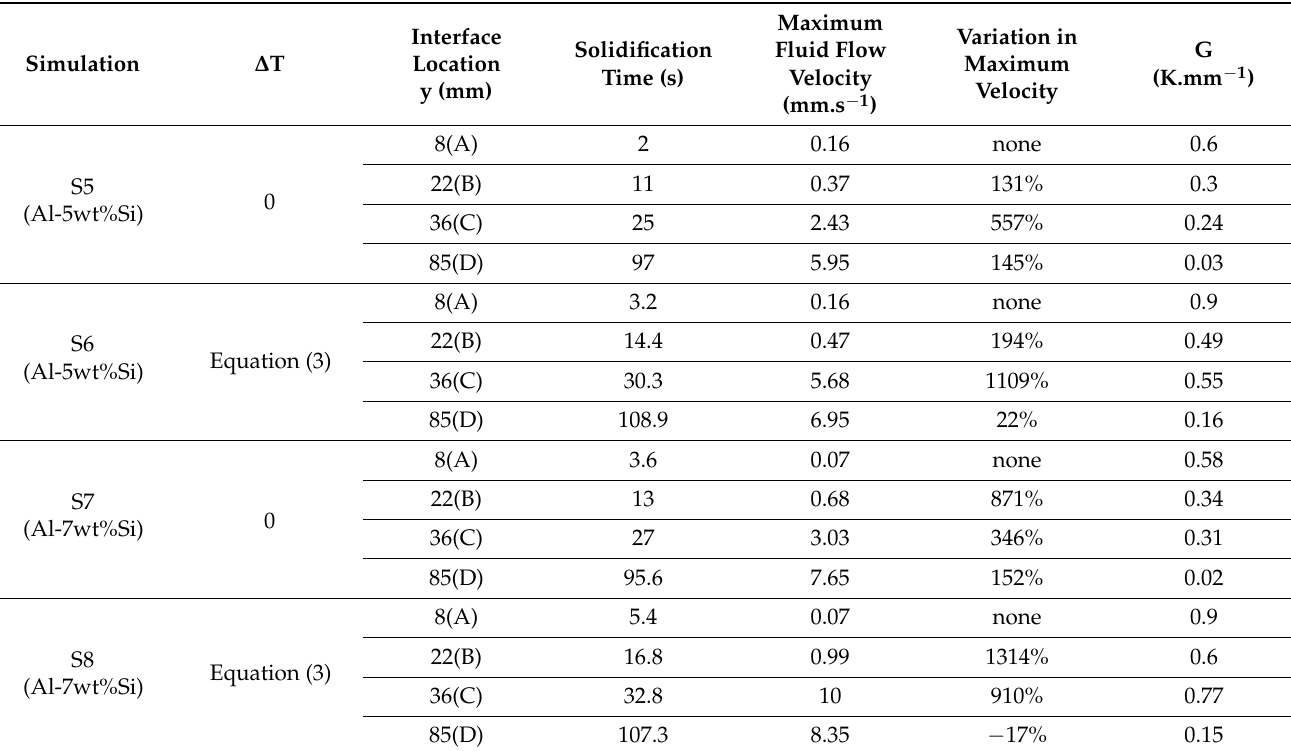
Table 6. Locations A, B, C and D shown in Figure 9c,d along with the solidification parameters at each